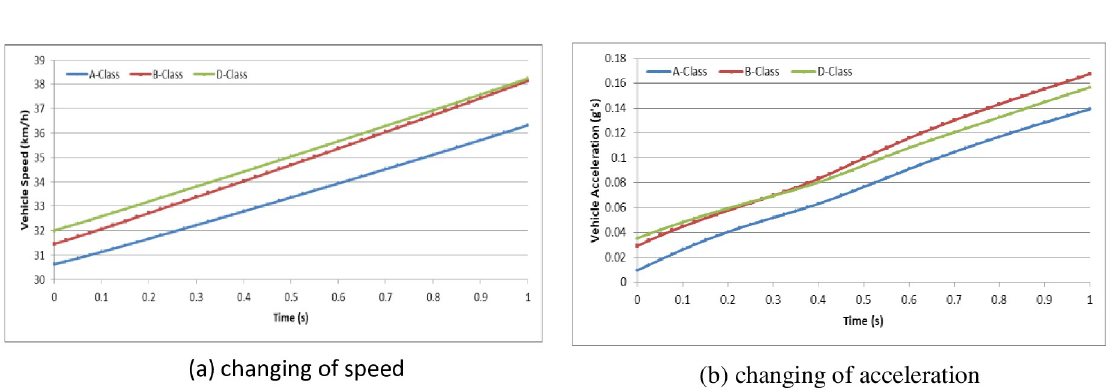
Fig 12. The changes in vehicle speed and acceleration during the reactions at initial speed = 70 km/h in different vehicle models (Group 1).